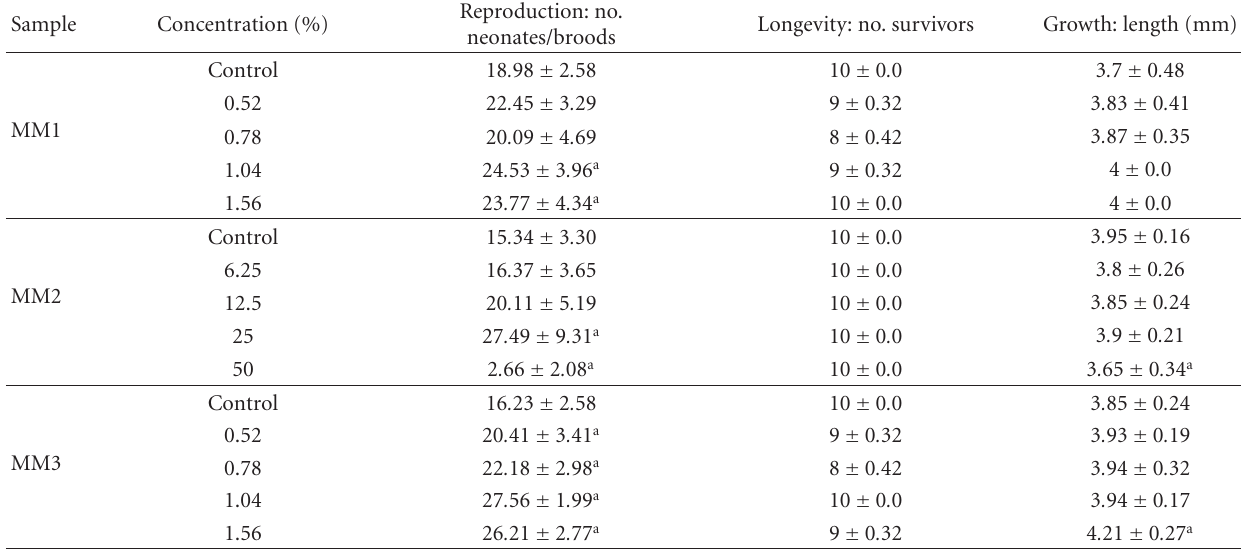
Table 4: E ff ects on reproduction, longevity and growth of Daphnia magna exposed to soluble fractions of metal-mechanic waste, samples MM1, MM2, and MM3, during 21 days. Results are expressed as means ± standard